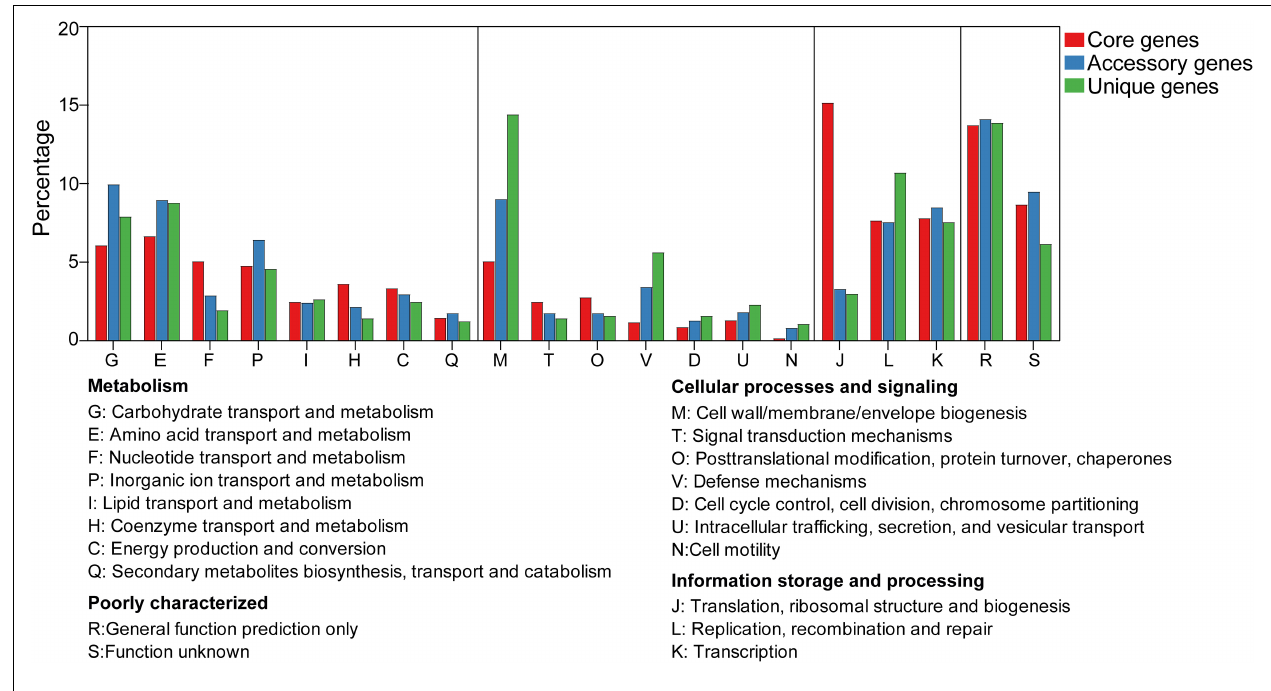
FIGURE 8 | Distribution of core, accessory, and unique genes on the COG category.